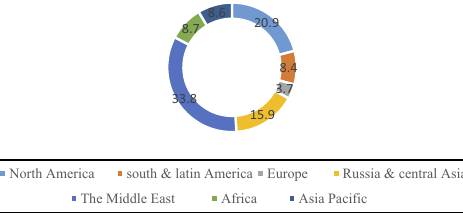
Figure 1. Oil production